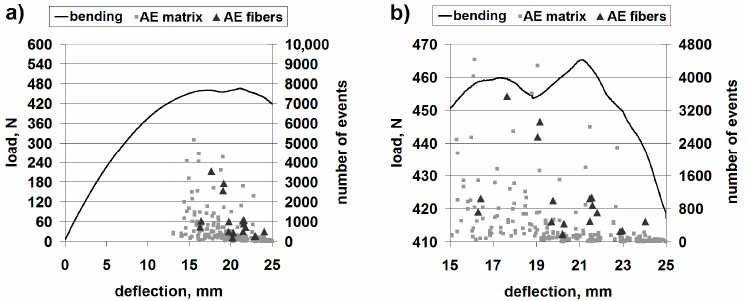
Figure 10. Mechanical curve and separated AE signal for 3D laminate, direction P : ( a ) The whole progress; ( b ) Magnification of the crucial fragment.